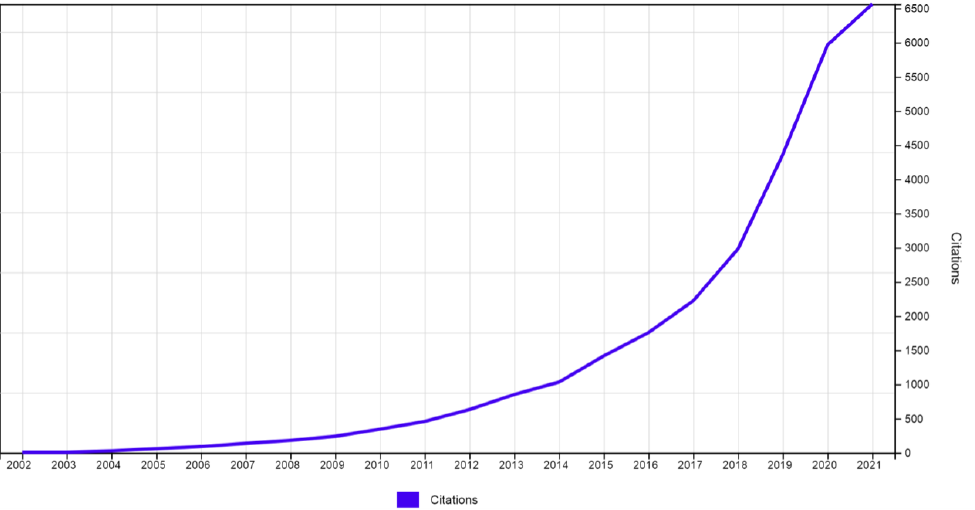
Figure 1. The annual citations between the period 2002–2022 retrieved from